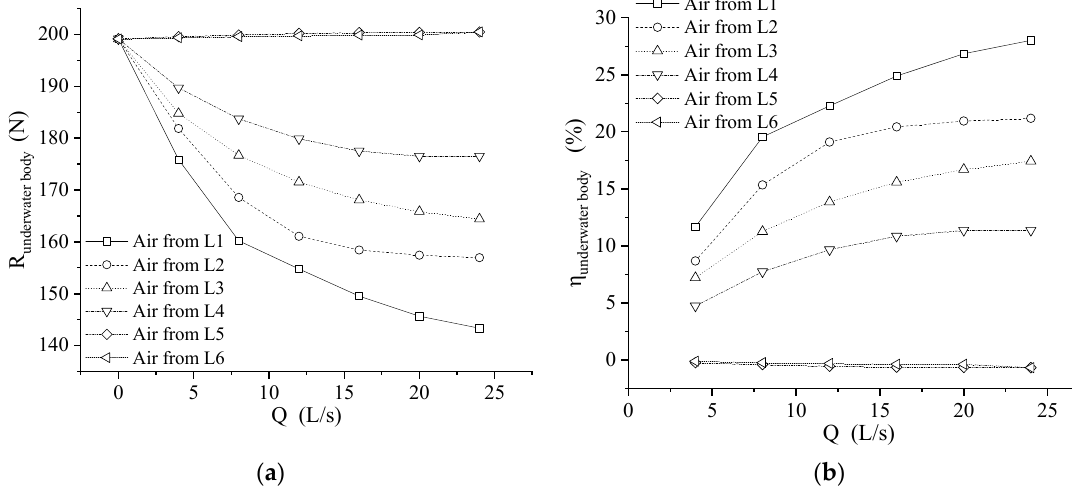
Figure 13. Resistance and drag reduction in the underwater body with different air injection locations: ( a ) Total resistance; ( b ) Drag reduction.